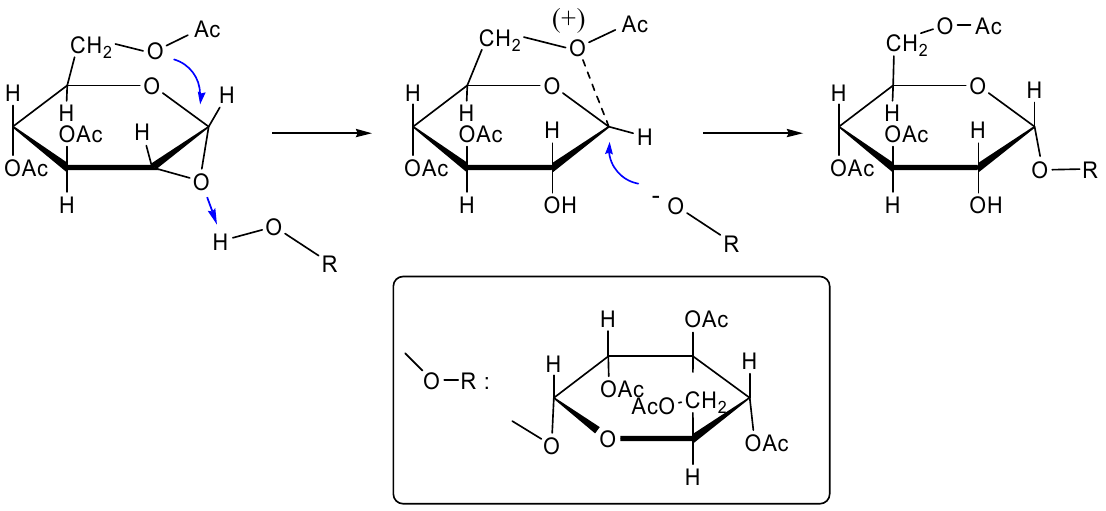
Figure 3. Chemical synthesis of α,α -trehalose by the method of Lemieux and Bauer